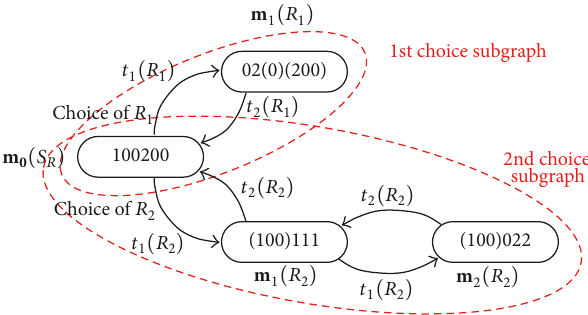
Figure 7: Union of the choice subgraphs of 𝑅 1 and 𝑅 2